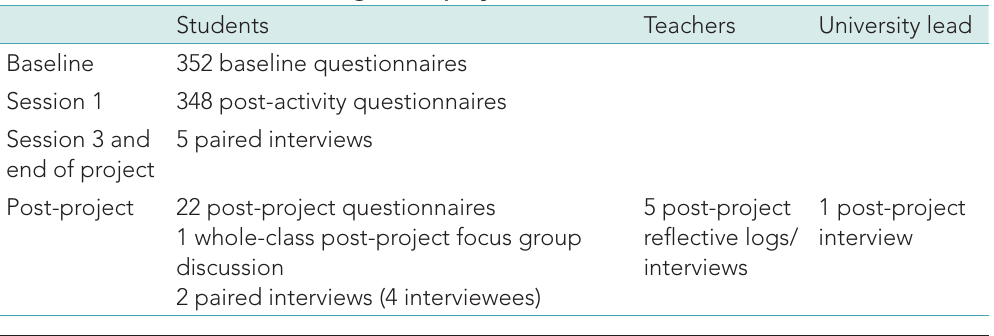
Table 1: Evaluation methodologies employed within the School Science